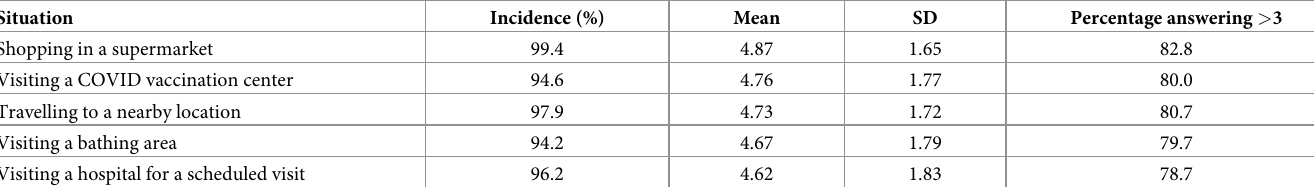
Table 1. Willingness to participate in in-the-moment surveys (0–6 point scales) in five specific